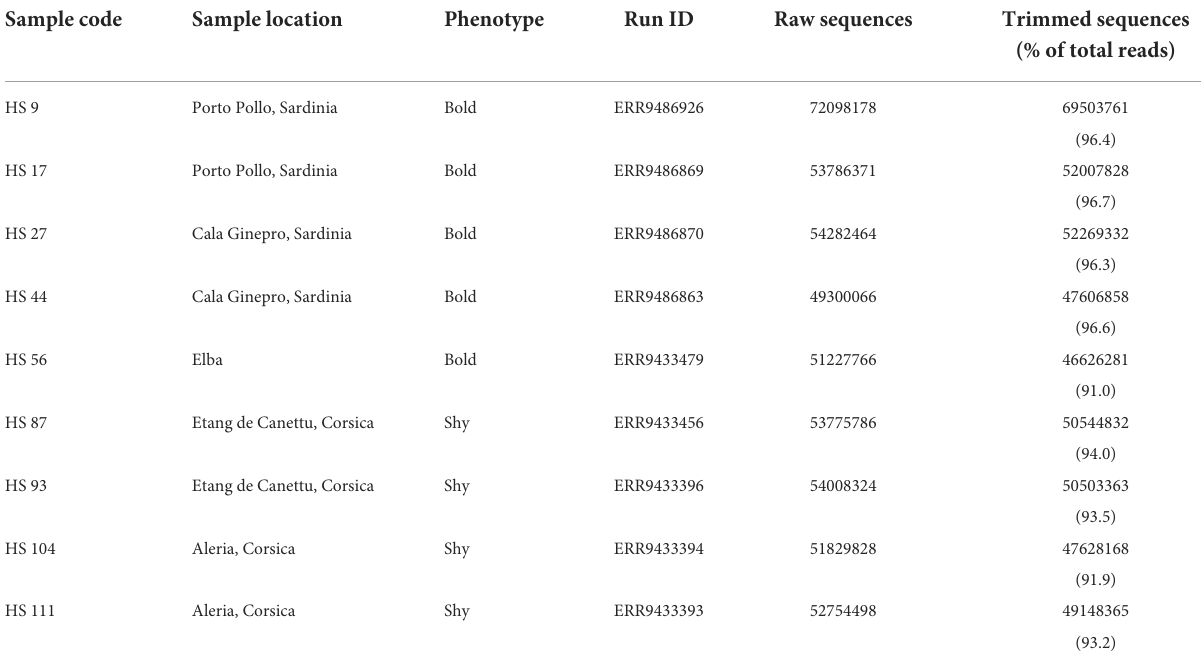
TABLE 1 Summary of the nine samples and of the associated data deposited in the ENA database (European Nucleotide Archive, Study Accession ID PRJEB51203) in terms of the number of raw and trimmed reads per sample. Sample